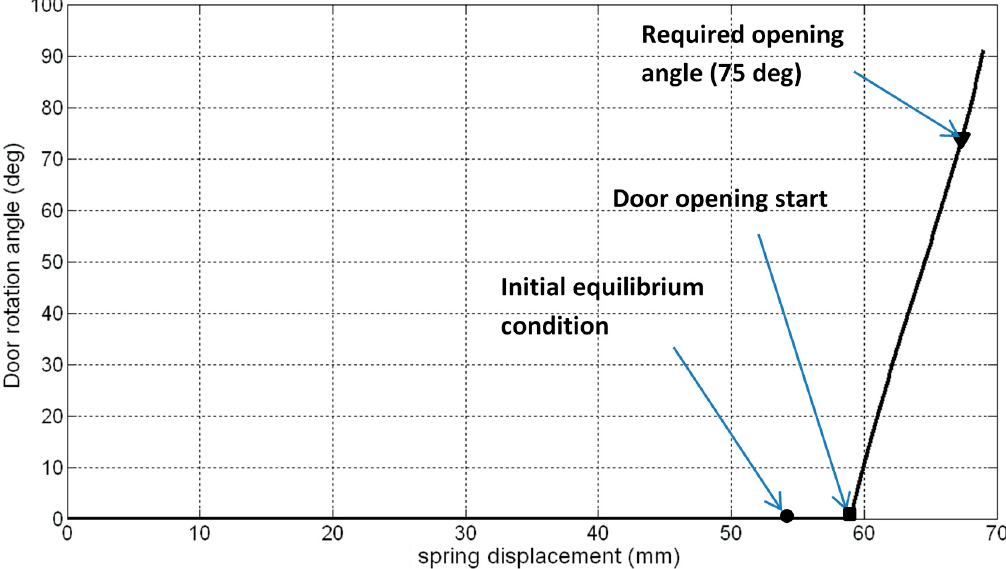
Figure 9. Door rotation vs. super elastic (SE) spring displacement.